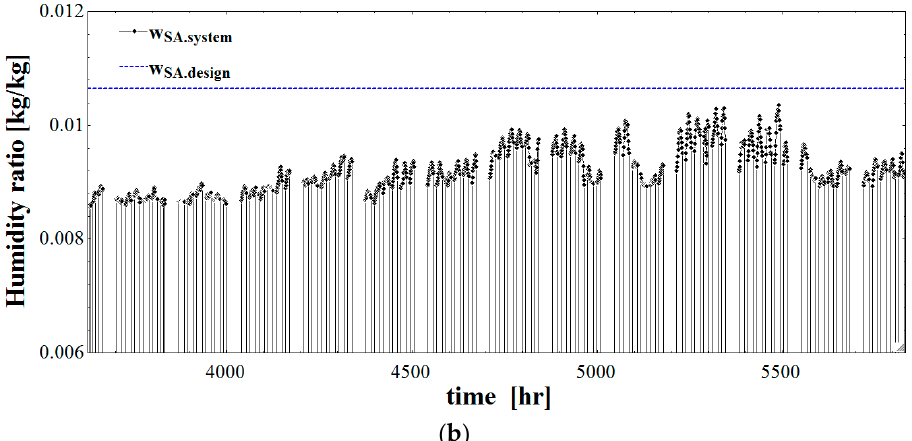
Figure 10. SA humidity ratio in the systems in the summer season. ( a ) SA humidity ratio of the conventional LD-IDECOAS; ( b ) SA humidity ratio of the proposed HPLD-IDECOAS.